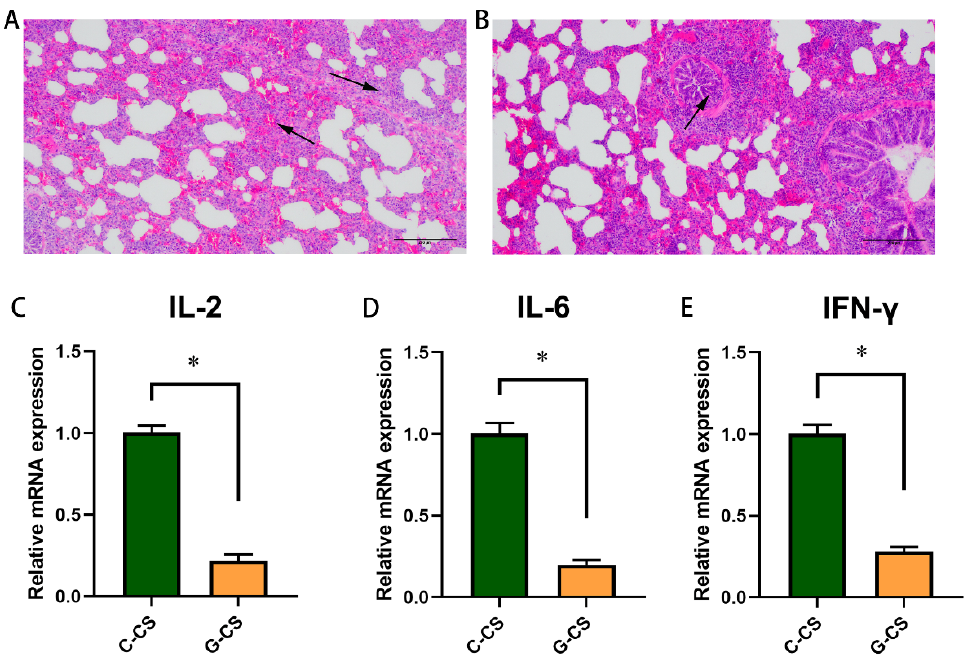
Figure 5. Lung injury assessment and inflammatory cytokines. ( A ) Hematoxylin and eosin (HE) in lung tissue of the cold stress control group (C-CS) group. ( B ) HE in lung tissue of the cold stress with glucose supplementation (G-CS) group. ( C ) IL-2 mRNA expression in lungs. ( D ) IL-6 mRNA expression in lungs. ( E ) IFN- γ mRNA expression in lungs. Data are expressed as the mean ± SEM, n = 6, * p < 0.05. Black arrows indicate inflammatory cell infiltration or abnormal development.